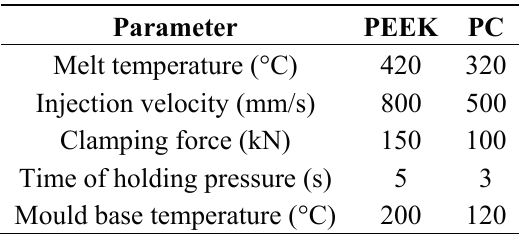
Table 1 . Injection moulding